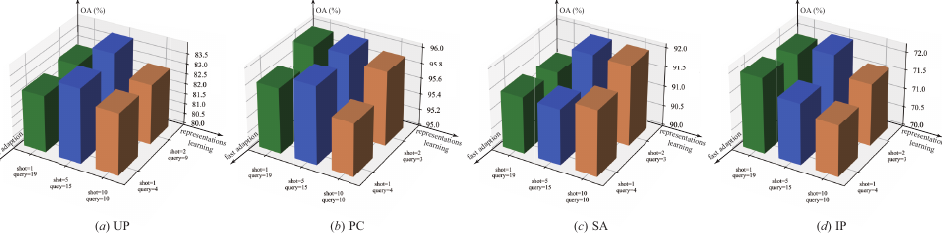
Figure 12. The results of the proposed method with different episode settings.